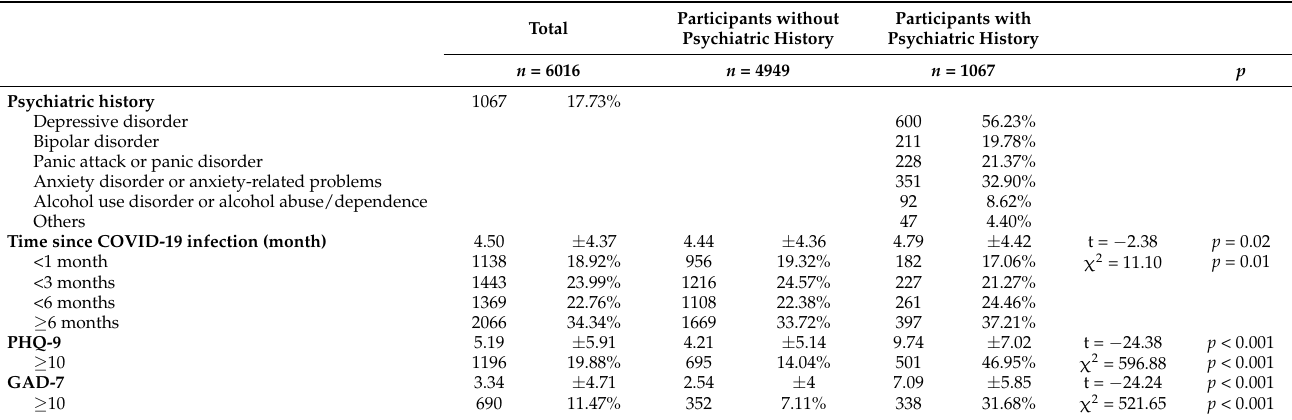
Table 1. Participant characteristics.